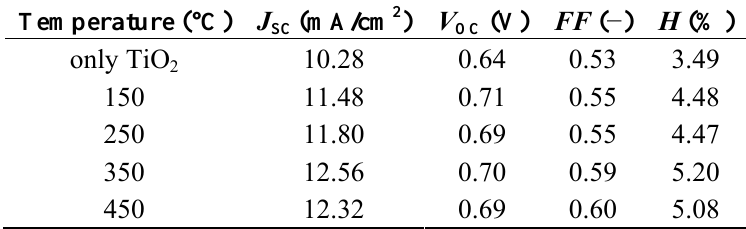
Table 1. Detailed cell parameters of DSSCs employing the TiO seed layer annealing temperatures under AM 1.5G